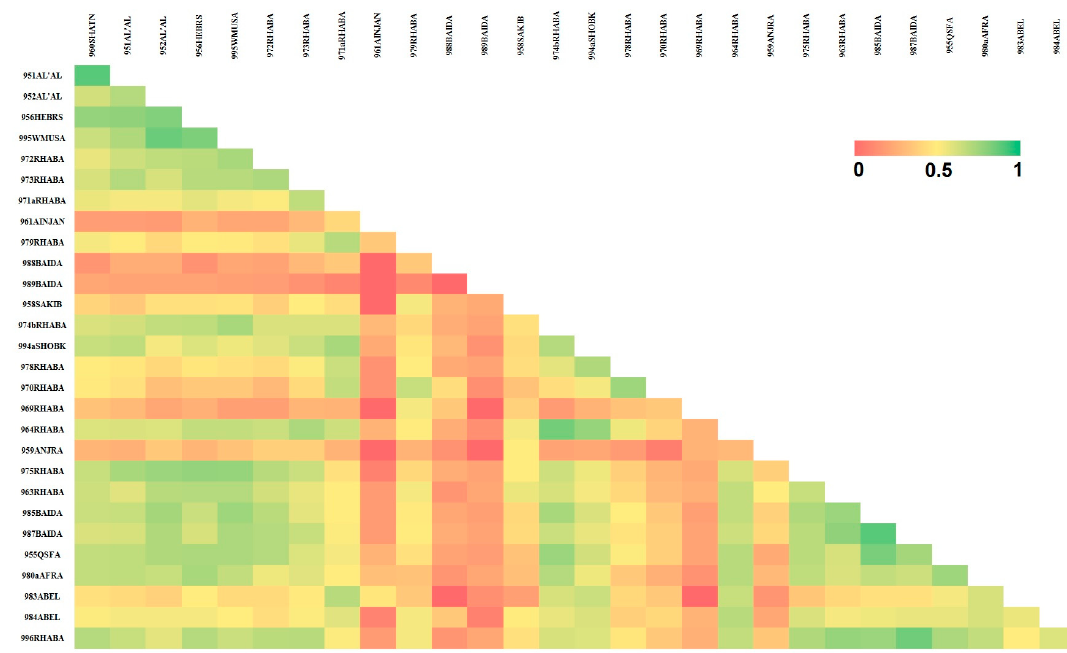
Figure 2. Jaccard’s similarity index (0–1) represented as a heatmap generated from developed SSR marker data for a collection of 29 tomato landraces (depicted as accession number and collection site).